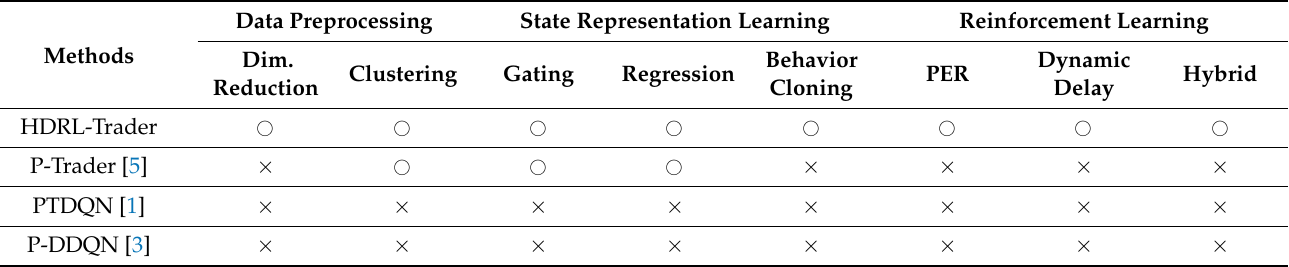
Table 2. Comparison of pairs trading methods.